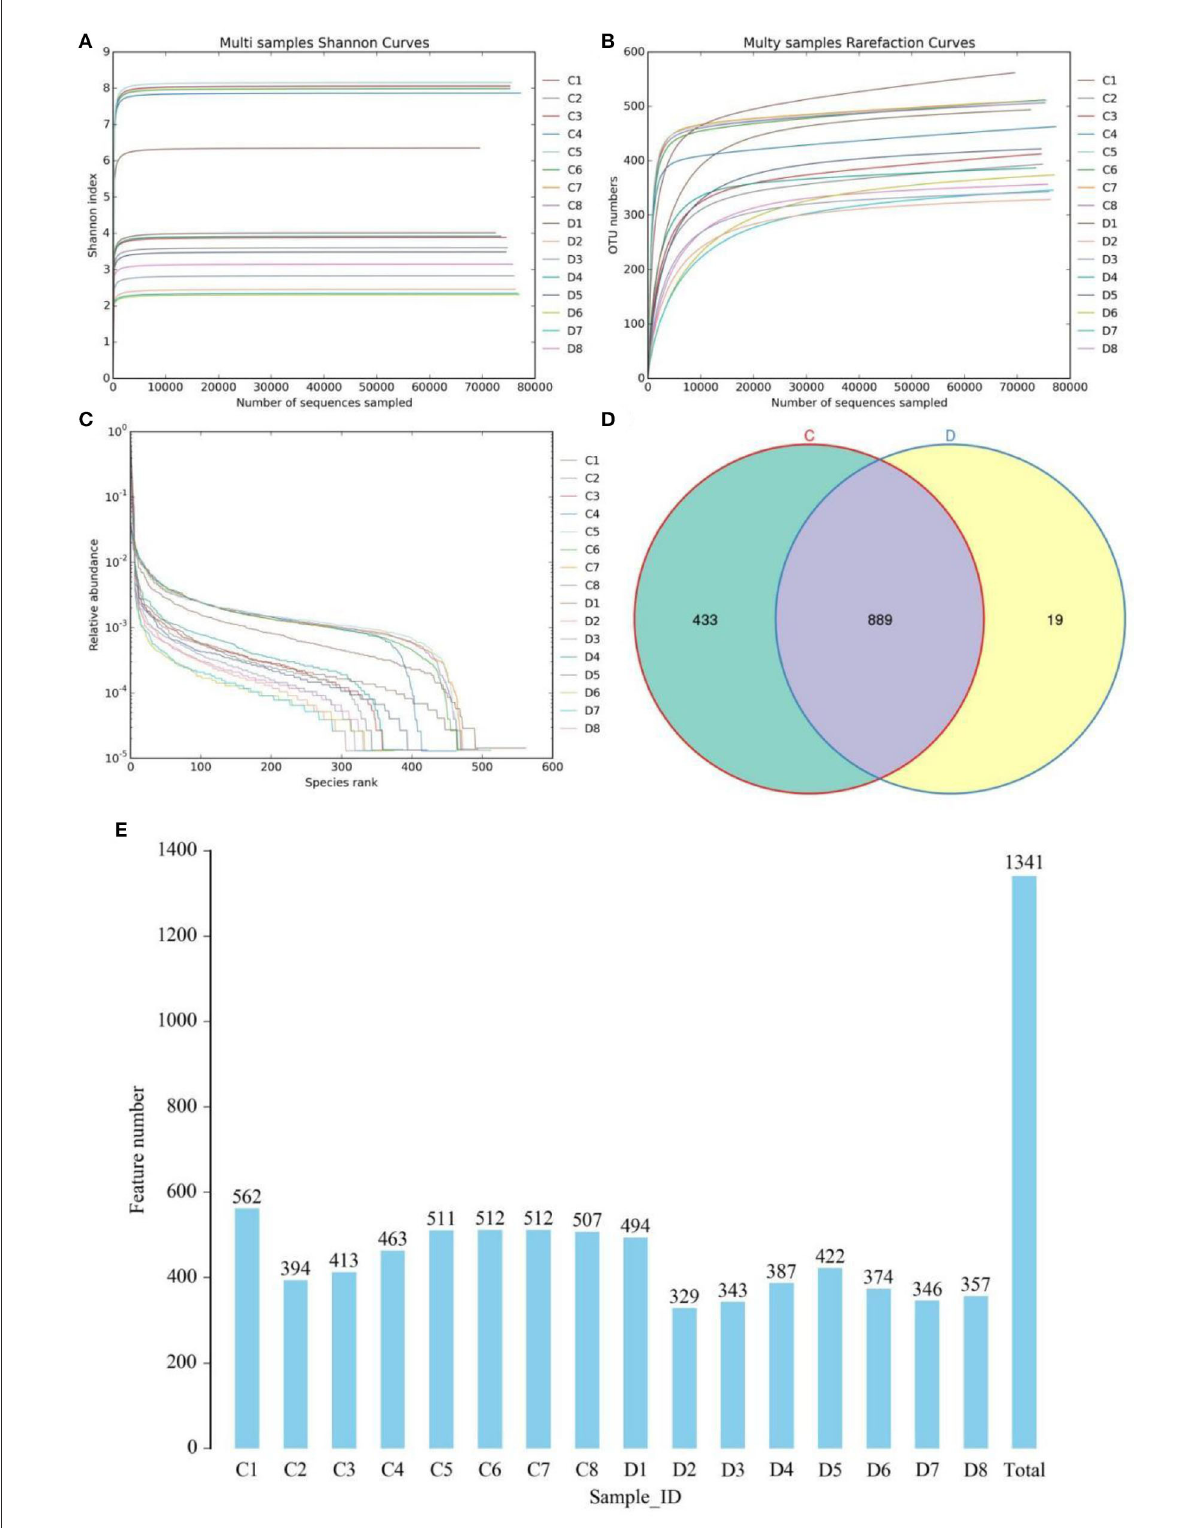
FIGURE1 Gut fungal feasibility analysis and OTUs distribution. Rarefaction curves (A,B) and rank abundance curve (C) were used to evaluate the sequencing depth and evenness. (D) Venn diagrams for core and unique OTUs in the healthy and diarrheic groups. Histogram showing the number of OTUs in each sample. (E) Histogram showing the number of OTUs in each sample. C and D represent healthy and diarrheic groups,